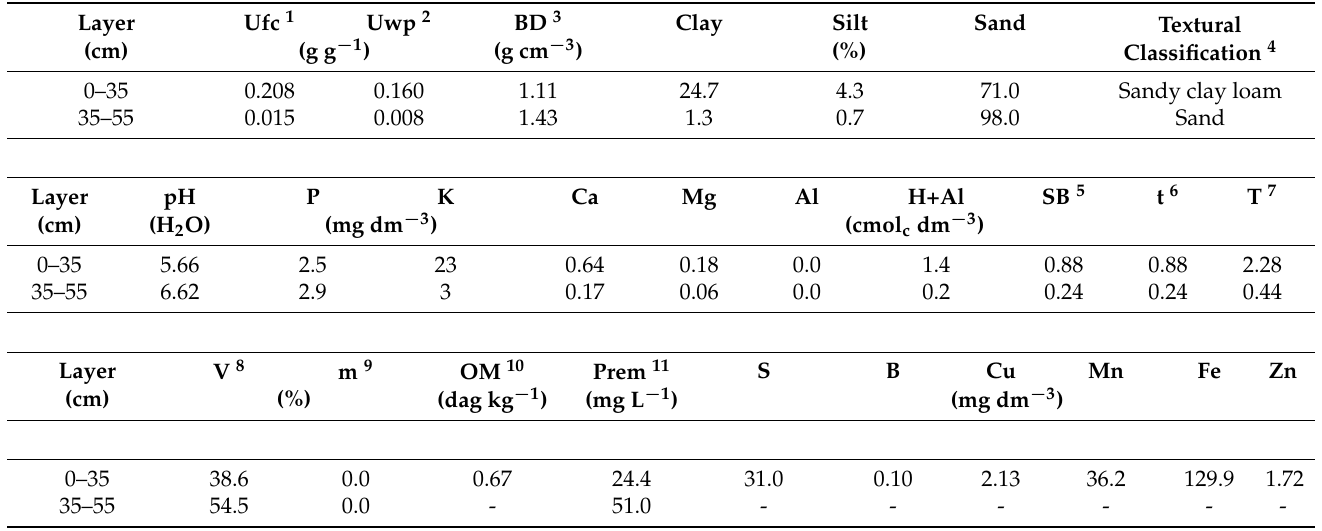
Table 1. Results of the physical-hydraulic and chemical analyses of the soil contained in the lysimeters before the